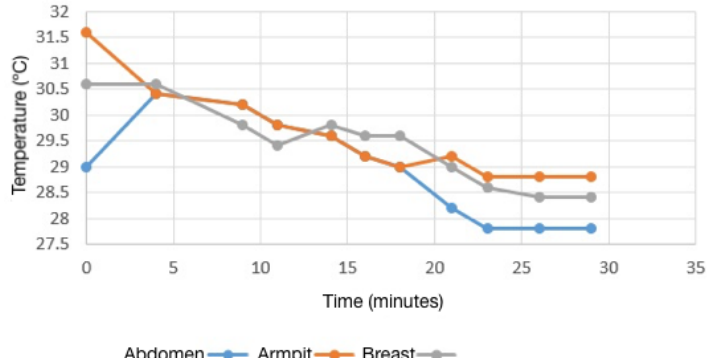
Figure 4. Temperature behavior of selected areas through